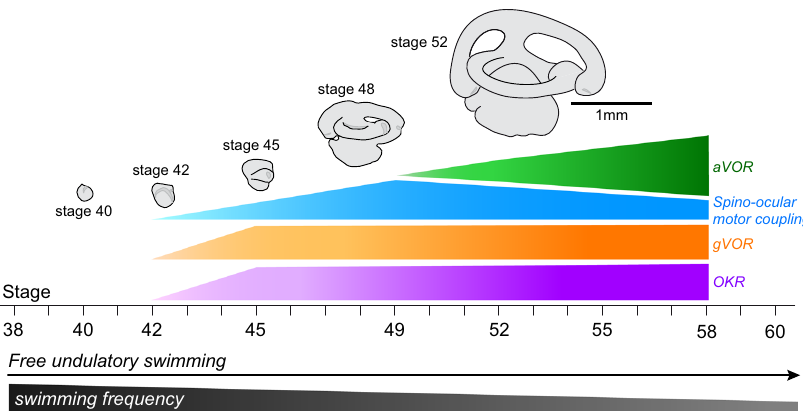
Fig. 7 Developmental onset and progression of gaze-stabilizing eye movements. Schematic depicting the ontogenetic onset and maturation of angular and gravitoinertial vestibulo-ocular re fl exes (aVOR, gVOR), the optokinetic re fl ex (OKR) and swim-related spino-ocular motor coupling with respect to larval stages and ongoing growth of inner ear endorgans. Note the color-coding of the different sensory-motor